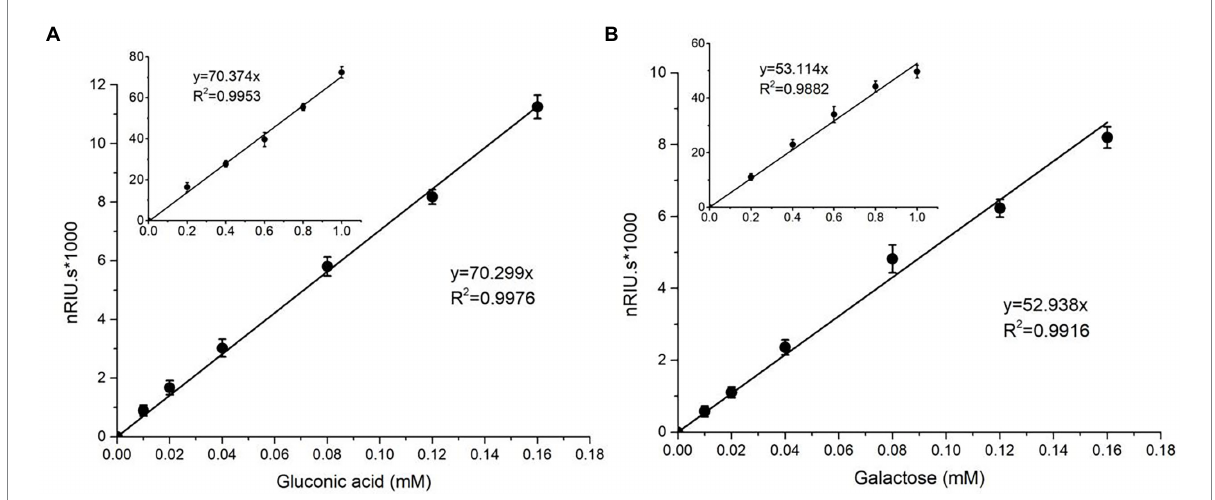
FIGURE 2 Standard curves of gluconic acid (A) and galactose (B) were analyzed using HPLC-RID. The standard curve ranges from 0.01 to 0.16 mM, and the inset is the same axial legend as the main graph, which shows the standard curve extending to 1.0 mM. All experiments were performed in three replicates, and error bars indicate the standard